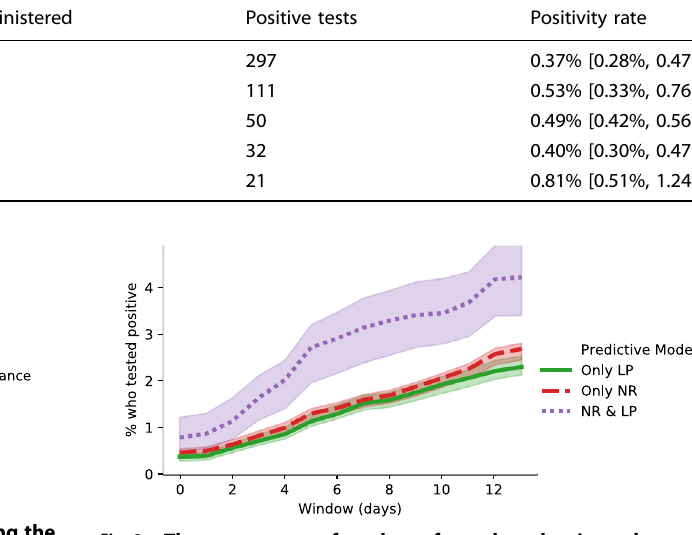
Fig. 2 The percentage of students from the adaptive cohort who tested positive as predicted by the node risk (NR) and/or link prediction (LP) models within 14 days. Day 0 is the day they were selected for the adaptive cohort. Shaded regions indicate 95% con fi dence intervals.